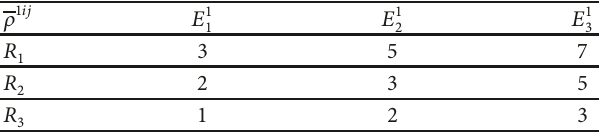
Table 3: The importance and ambiguity of